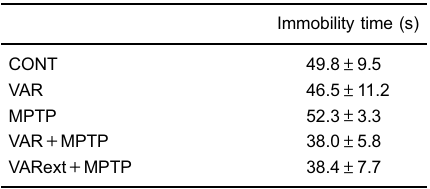
Table 1. Effect of chronic varenicline exposure on forced swimming test